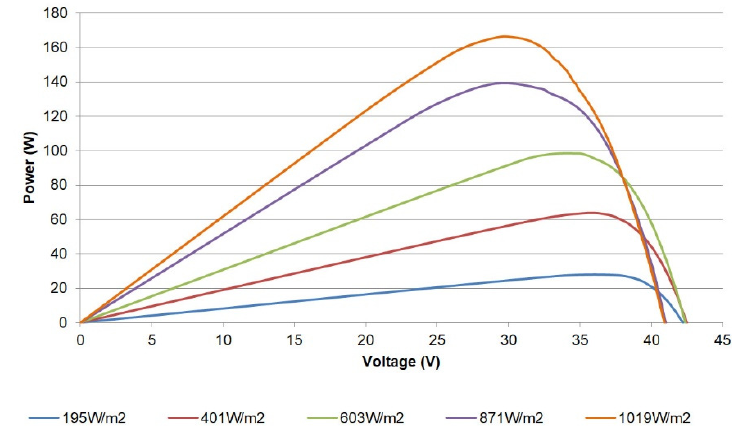
Figure 15. P ‐ V curves for a single PV module. Figure 15. P-V curves for a single PV